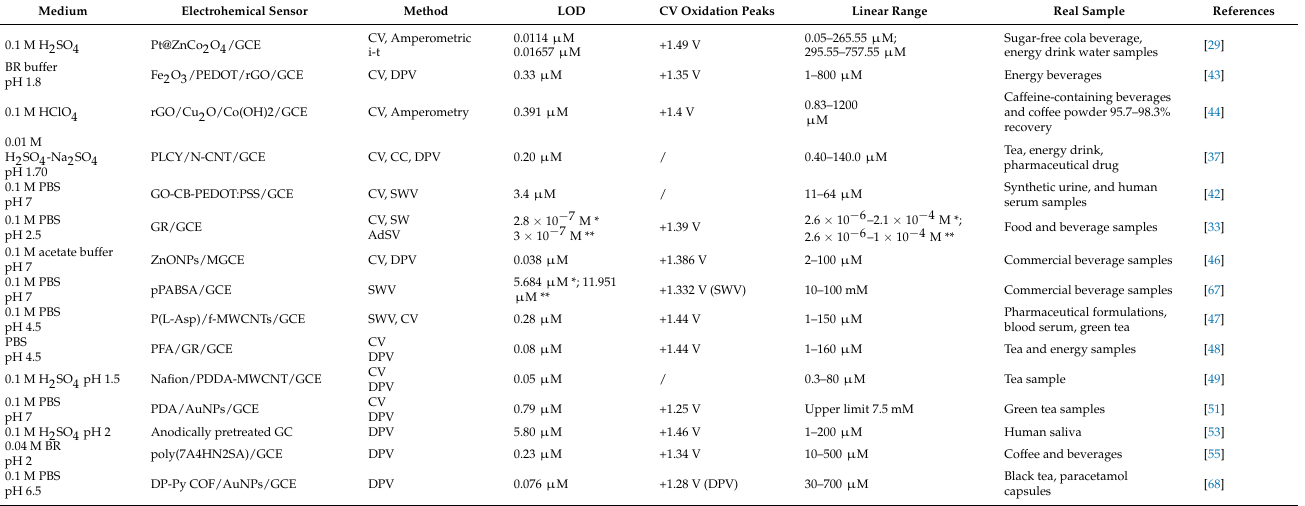
Table 1. Electrochemical characteristics of glassy carbon electrode as sensor for caffeine